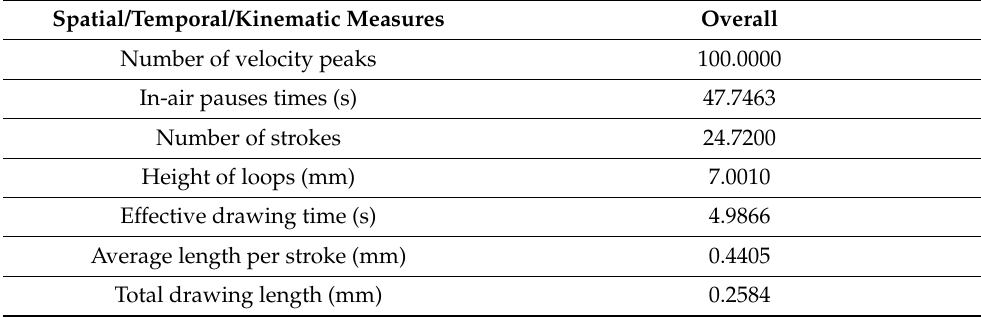
Table 5. Variable importance to diagnose handwriting disorders.